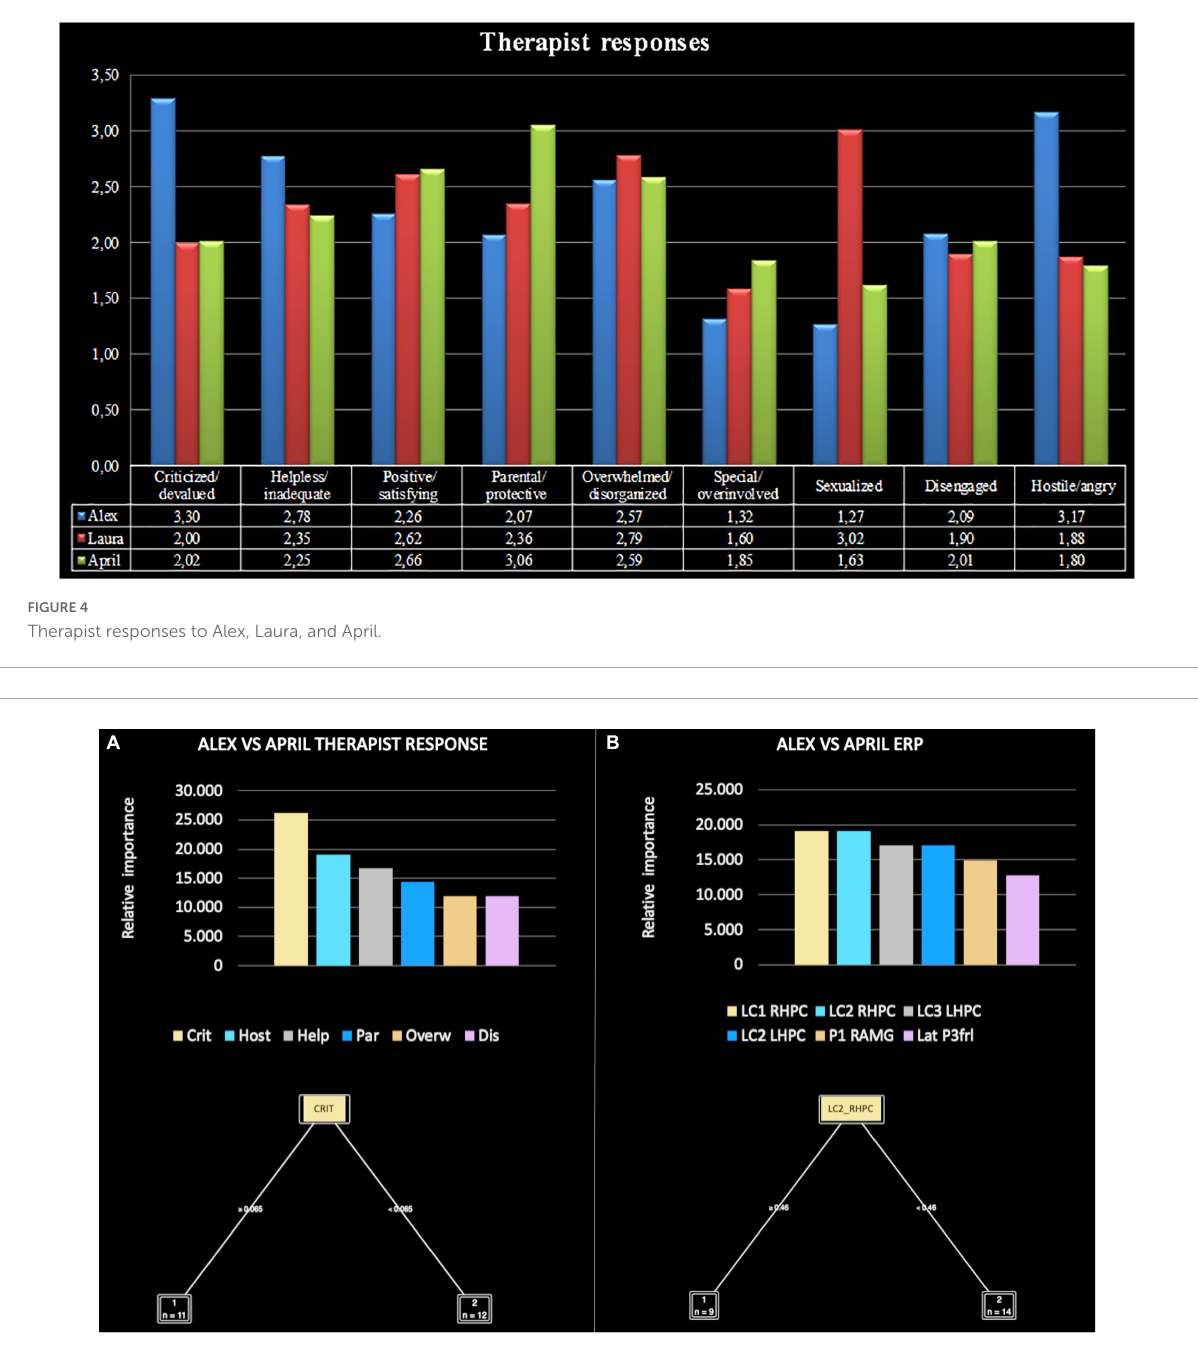
FIGURE5 Relative importance of all therapist response patterns (A) and event-related potential (ERP) components (B) , included in the machine learning (ML) model for Alex versus April.